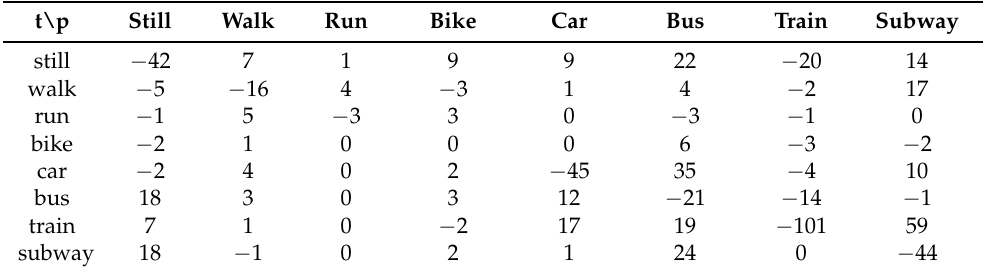
Table 7. The difference confusion matrix of the network trained without the linear acceleration software sensor. The largest loss in classification occurred in the class subway and the smallest in class run . t = true label, p = predicted label.